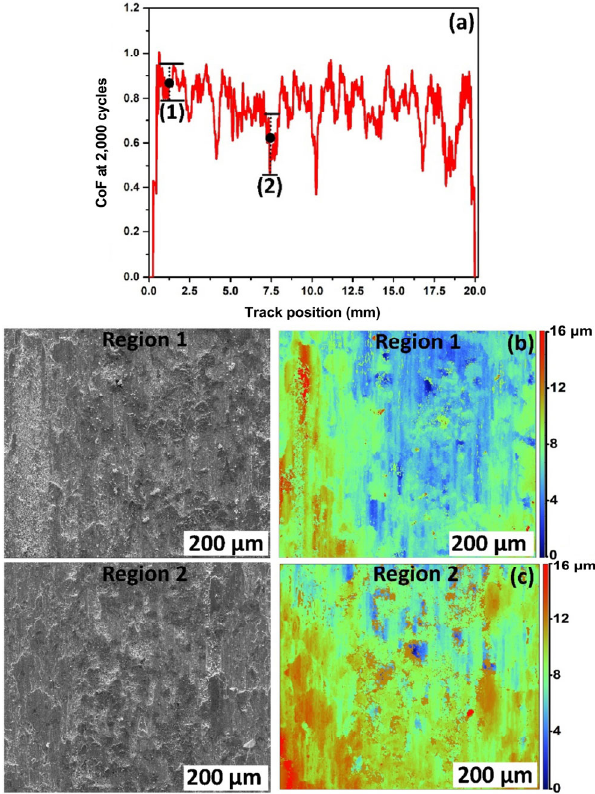
Fig. 13 (a) CoF with track position at the end of the test (2,000 cycles) showing: (b) elevated Fe substrate and (c) scattered and less elevated Fe substrate.